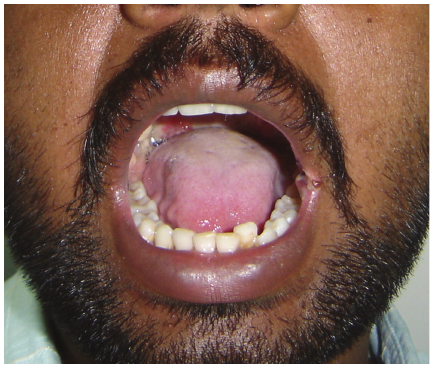
Figure 10: Postoperative